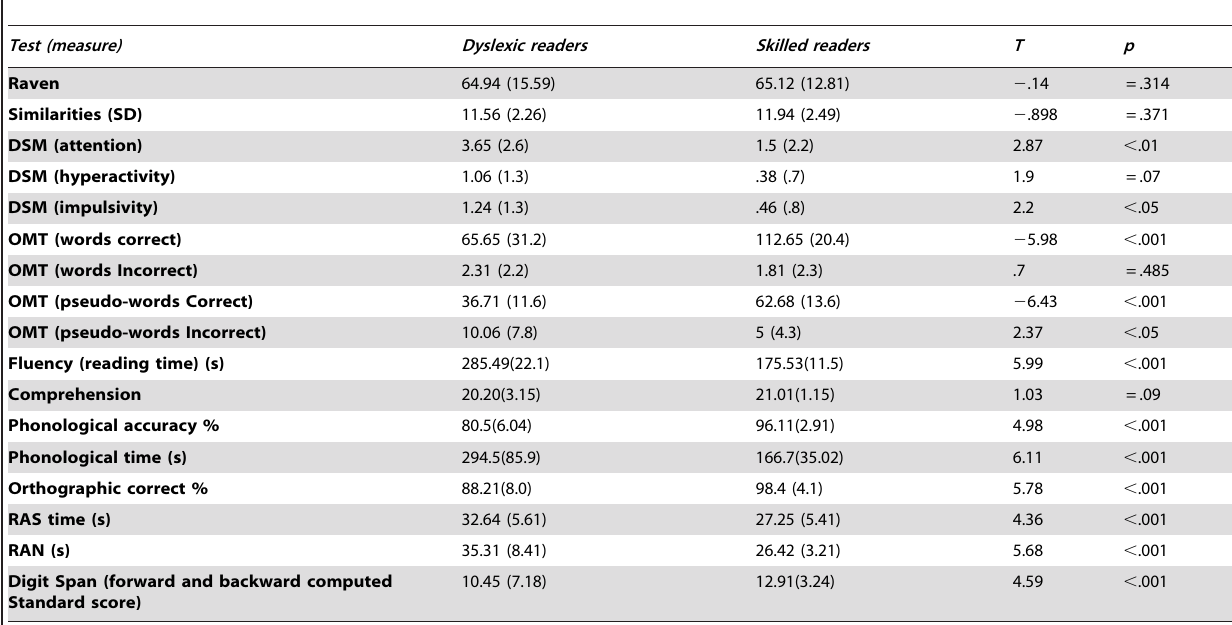
Table 1. Performance of dyslexic and skilled readers on the IQ tests, the DSM-IV, OMT, background, and reading measurements.